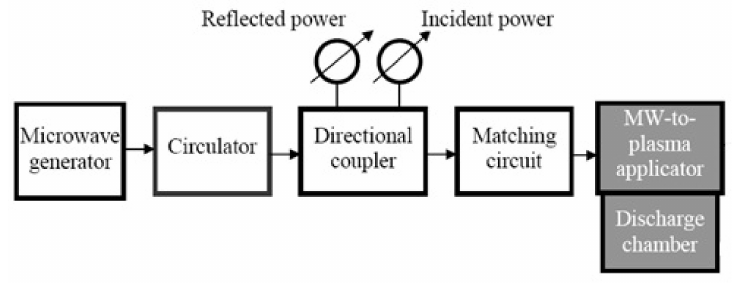
Figure 1. The general scheme of microwave discharges setup. Various microwave-to-plasma applicators are used for generation of microwave dis- charges in different liquid dielectrics. Their task is to create the microwave field, having the strength sufficient to create and sustain a discharge in the gas bubble. There are four main types of discharge devices (Figure 2). Plasma is generated near microwave antennas of different